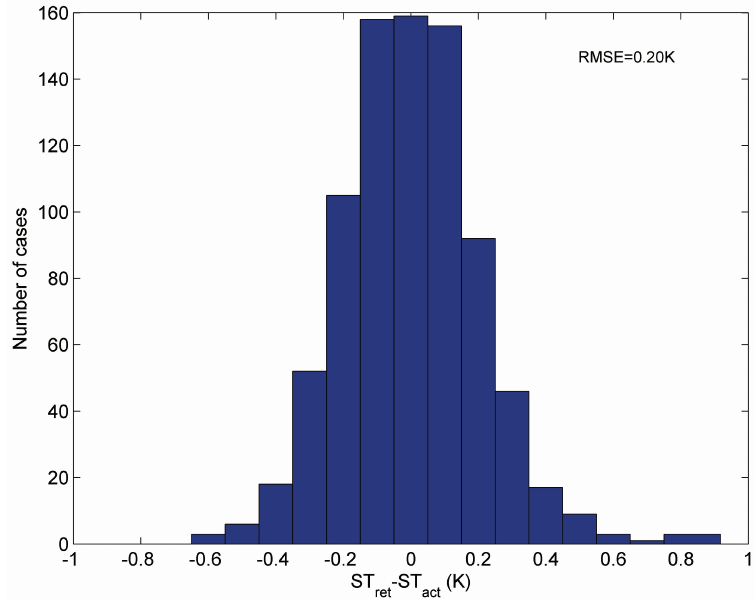
Figure 5. Error of the ST retrieved by Equation (3) from simulation data with the 139 atmospheric profiles. (ST ret = the retrieved ST, ST act = the true ST).